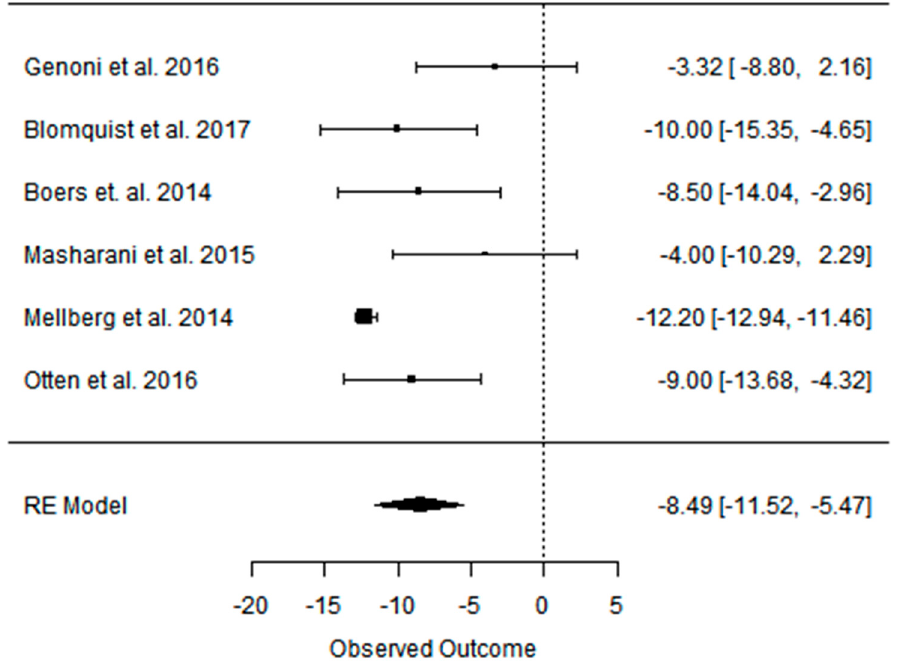
Figure A35. Forest plot of the effect of PD on SBP in the short term (weighted mean difference).